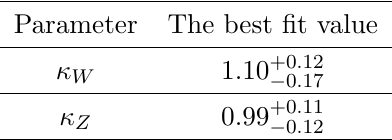
Table 1. The best (cid:12)t values and (cid:6) 1 (cid:27) uncertainties for (cid:20) V .